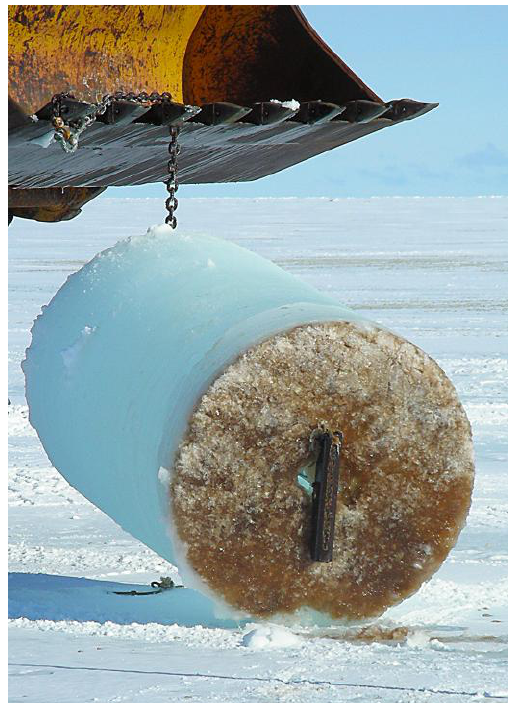
Figure 1. Cross-section of sea ice. A distinct brown coloration is present at the bottom 20 cm of a 1 m diameter section of sea ice. This is due to the high concentration of bacteria and microalgae within the sea